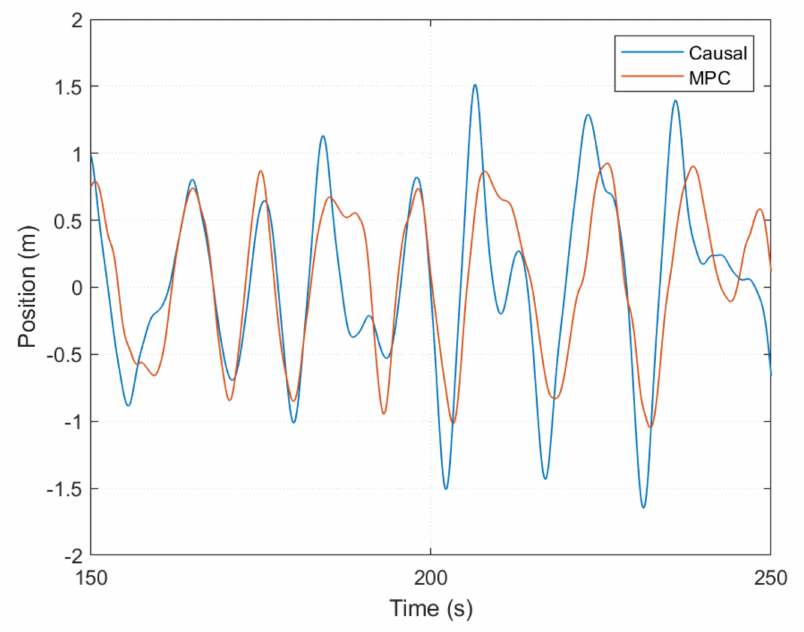
Figure 18. Time domain response comparison of WEC position with PTO force limit = 0.5 MN. Significant wave height Hs = 1.0 m, peak period Tp = 16